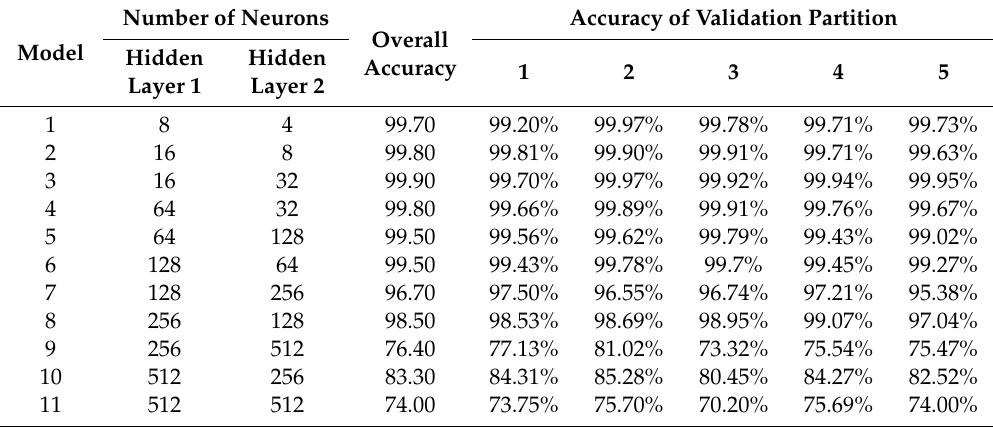
Table 8. Validation result of training using dataset B (26 July 2019 interval).